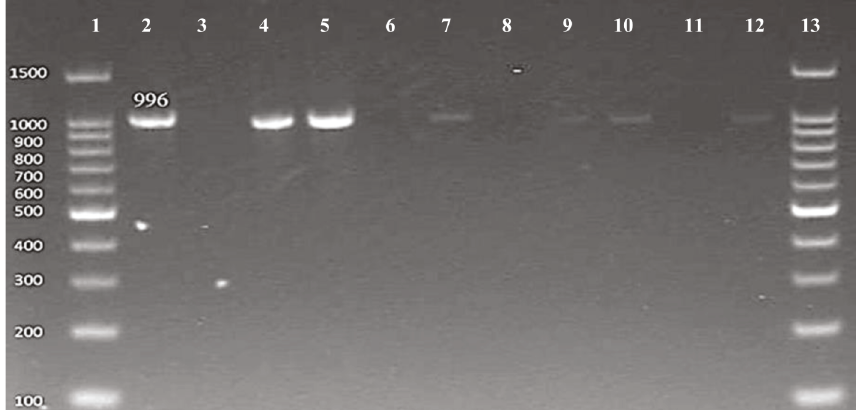
Figure 3: Molecular detection of ESBLs ( blaCTX-M -15) gene (996 bp). Number 1 and 13: 100bp DNA ladder; number 2: positive control; number 3, 6, 8, 11: negative samples; number 4, 5, 7, 9, 10, 12: positive samples.